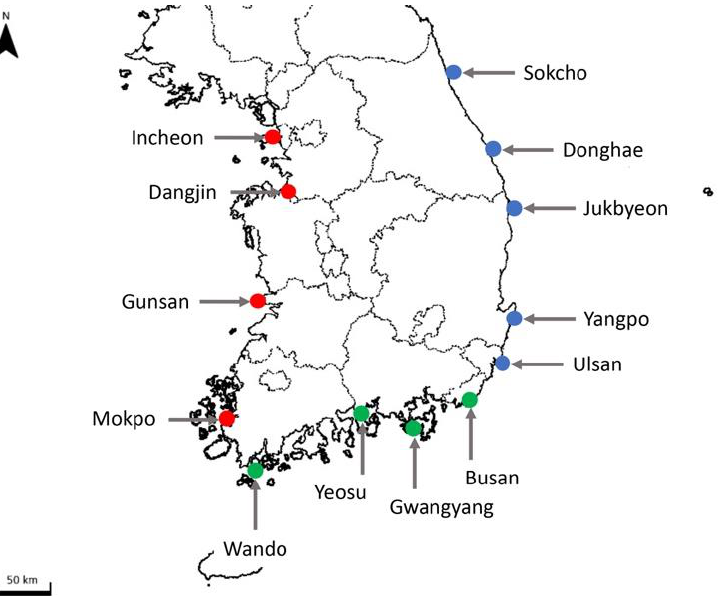
Figure 1. Sampling localities in this study. Locality marks were filled in different colors by region: blue — East Sea; green — Korea Strait; red — Yellow Sea.